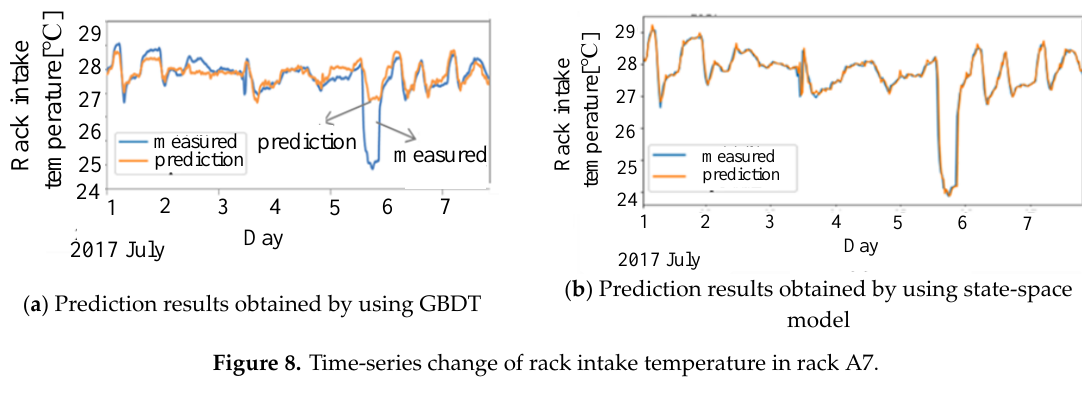
Table 7. Methods selected as a candidate for rack intake temperature prediction model.